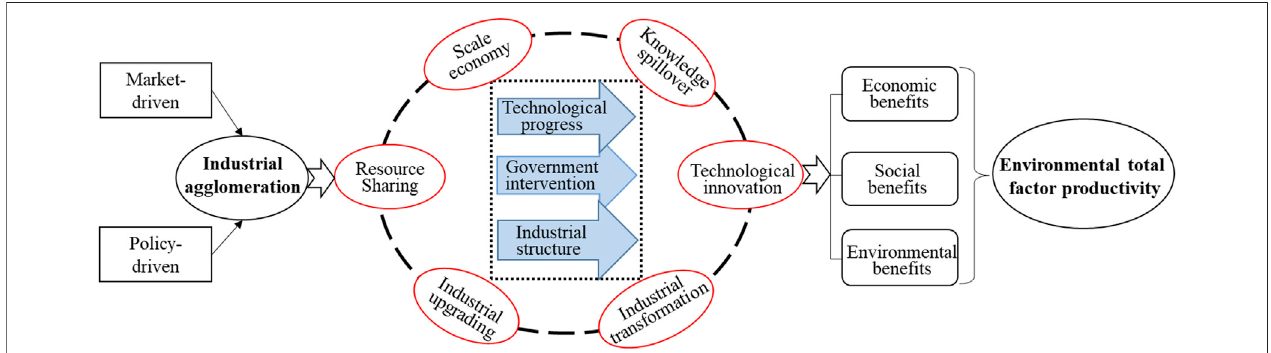
FIGURE 1 | Mechanism of industrial agglomeration in fl uencing environmental total factor